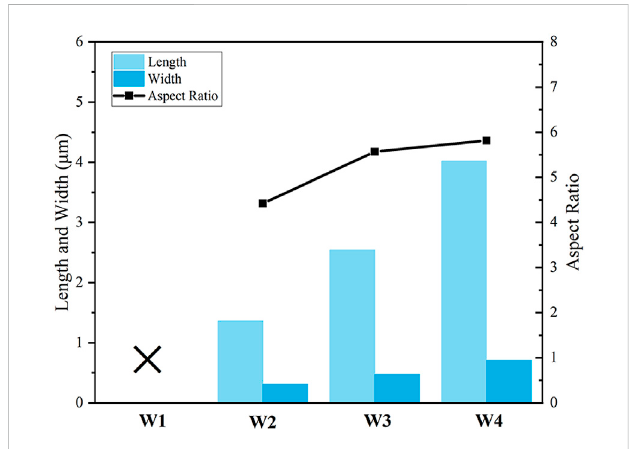
FIGURE 6 Crystal size of LD glass-ceramics treated by different temperature.